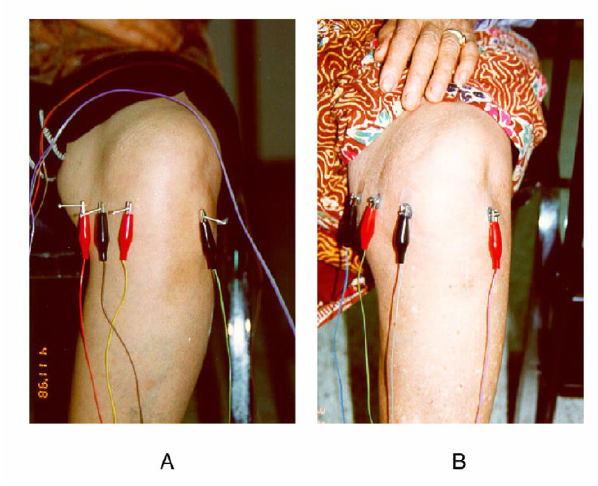
Figure 1 The selected acupuncture points around the knee, demon- strated in sitting position, during treatment with true (A) and placebo EA